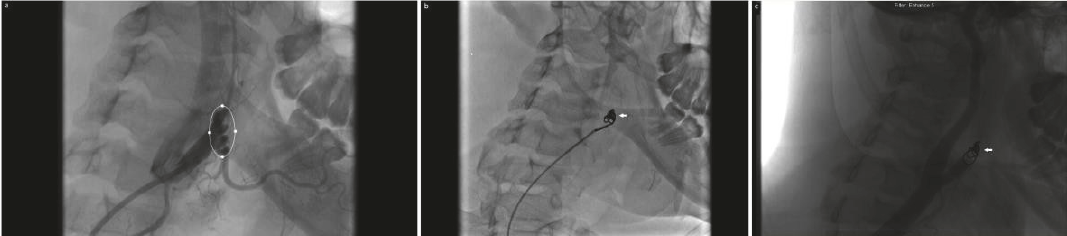
Figure2:Rightcarotidarterycineangiographyseries.(a)Preintervention:thewhiteellipseencirclestheexternalcarotidarterydissectionwith contrast extravasation. (b) Intervention: The white arrow indicates successful coil embolization with 0.018” and 0.035” Tornado (cid:2) embolization coils (Cook Medical (cid:2) LLC, Bloomington, IN, USA). (c) Postintervention: the white arrow indicates complete occlusion of the external carotid artery distal to the superior thyroid branch; with no antegrade flow within the